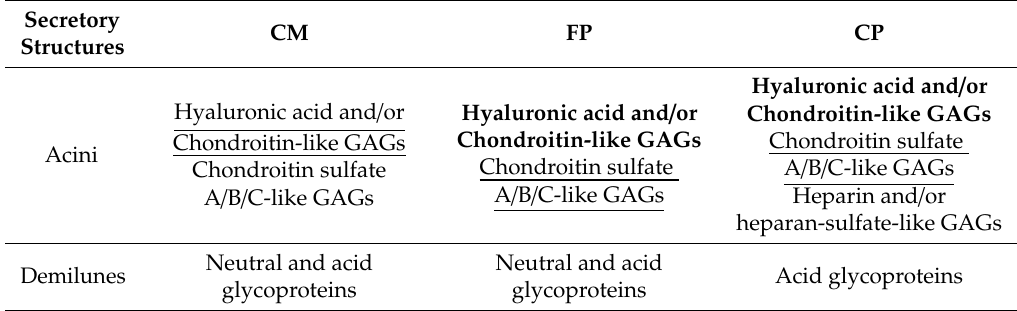
Table 5. Kinds of glycoconjugates produced by the pig mandibular gland (MG) secretory structures, listed in descending order as also evidenced by a di ff erentiated